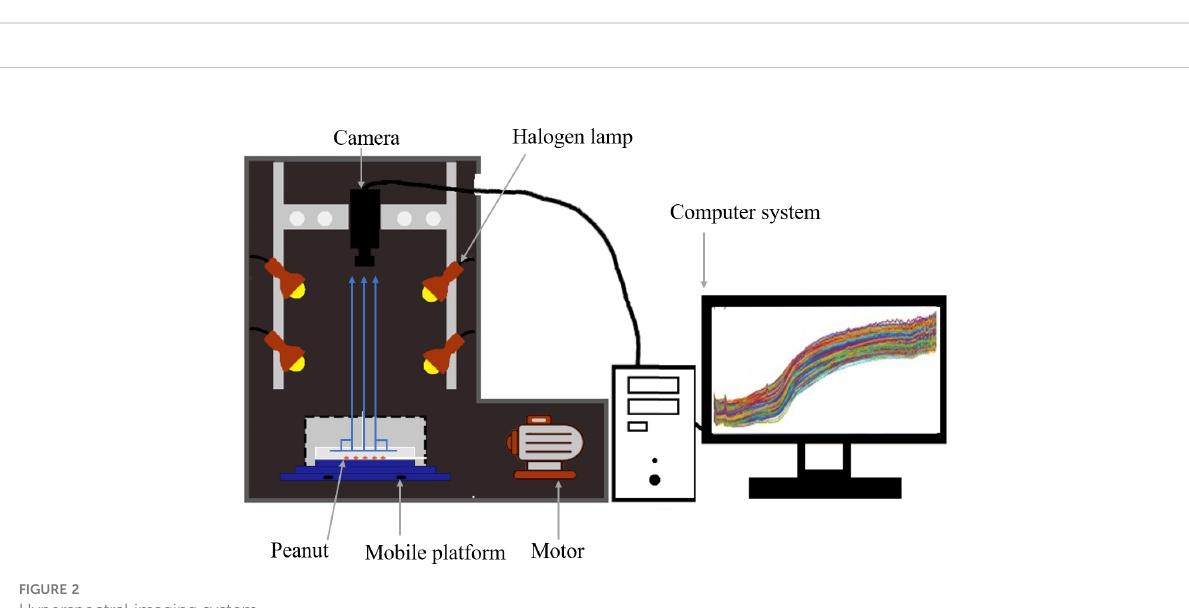
FIGURE 2 Hyperspectral imaging system.